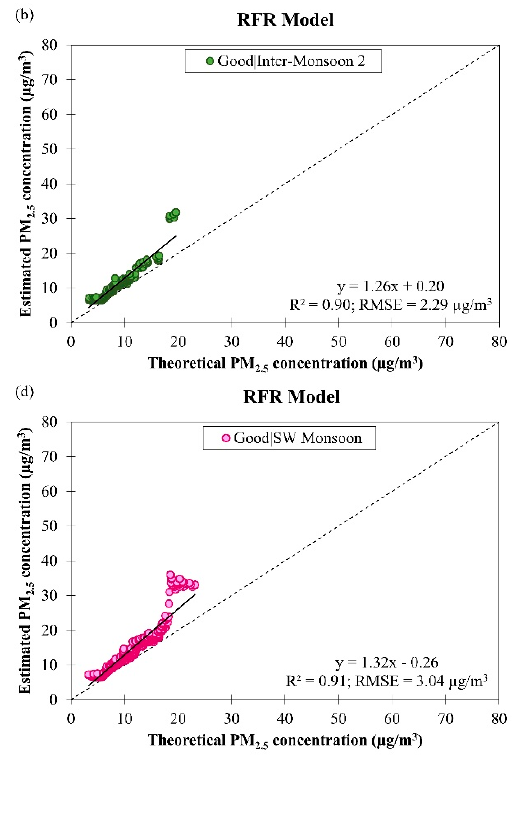
26 of 34 Table 5. Comparison of determination coefficient ( 𝑅 (cid:2870) ) and root mean square of the errors (RMSE) of the ANCOVA and RFR models for estimating daily PM 2.5 and PM 10 concentrations during good and moderate air quality conditions in different monsoon seasons in Brunei Darussalam from Jan- uary 2009 to December 2019. Air Quality Condi- tion|Monsoon Season